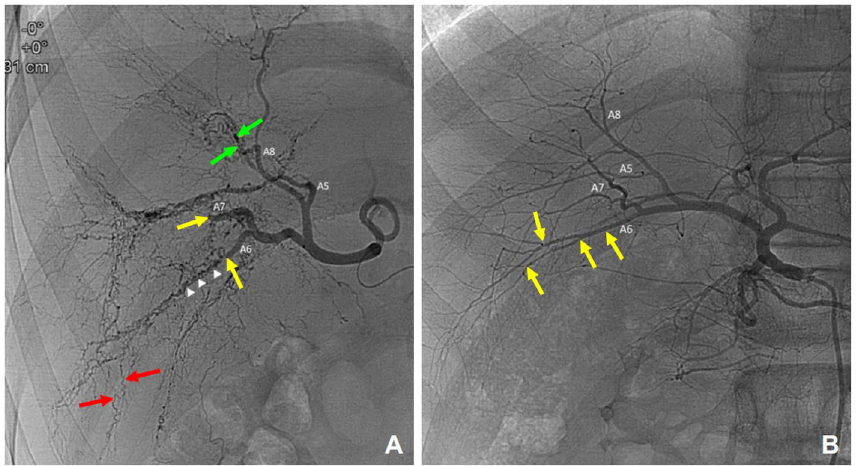
Figure 4. Comparison of visceral angiograms between the patient’s hepatic artery ( A ) and a normal hepatic artery ( B ). Overall, the “pruned branches” is a sign of normal peripheral hepatic arteries with extensive intrahepatic corkscrew and tortuous collateral arteries ( A ). Abrupt cut-off of second order branch of the hepatic artery types A6 and A7 (yellow arrows). Fine corkscrew collateral arteries along the A6 running course that replaces the normal A6 branch (white arrow heads). Intrahepatic tortuous collateral arteries developed in the peripheral liver (red arrows). Multiple stenosis and focal ectasia of the segmental hepatic artery (A8). This lead to the complete obstruction of the arteries and subsequent collateral development (green arrows). The normal A6 hepatic artery ( B ) showed typical smooth peripheral tapering out of the segmental hepatic artery (A6) with side-by-side ramification of the intrahepatic branches (yellow arrows).